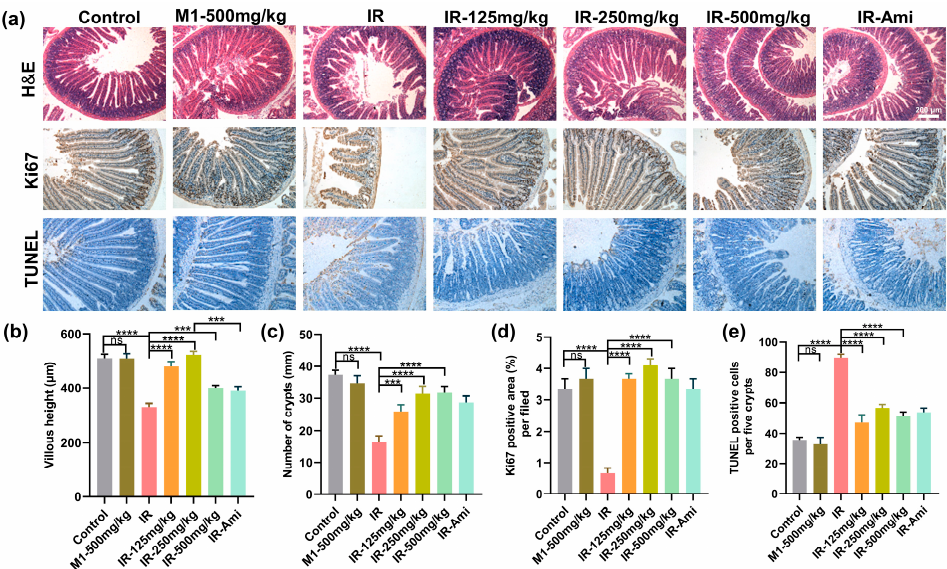
Figure 7. ( a ) Representative images showing the structure in cross-sections of the small intestine with hematoxylin and eosin (H&E), Ki67, and TUNEL staining. Scale bar: 200 µ m. ( b – e ) Histogram showing the number of crypts, villus lengths, and Ki67 positive and TUNEL positive cells in intestinal sections from the control, IR, M1-500 mg/kg, IR + 125 mg/kg, IR + 250 mg/kg, IR + 500 mg/kg, and IR + Ami groups. The results are represented as mean ± SEM, n = 6 mice per group. *** p < 0.001, **** p < 0.0001 by one-way analysis of variance (ANOVA).